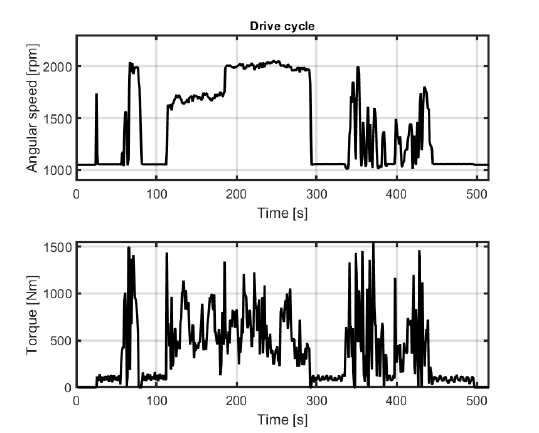
Figure 15: The load cycle of the